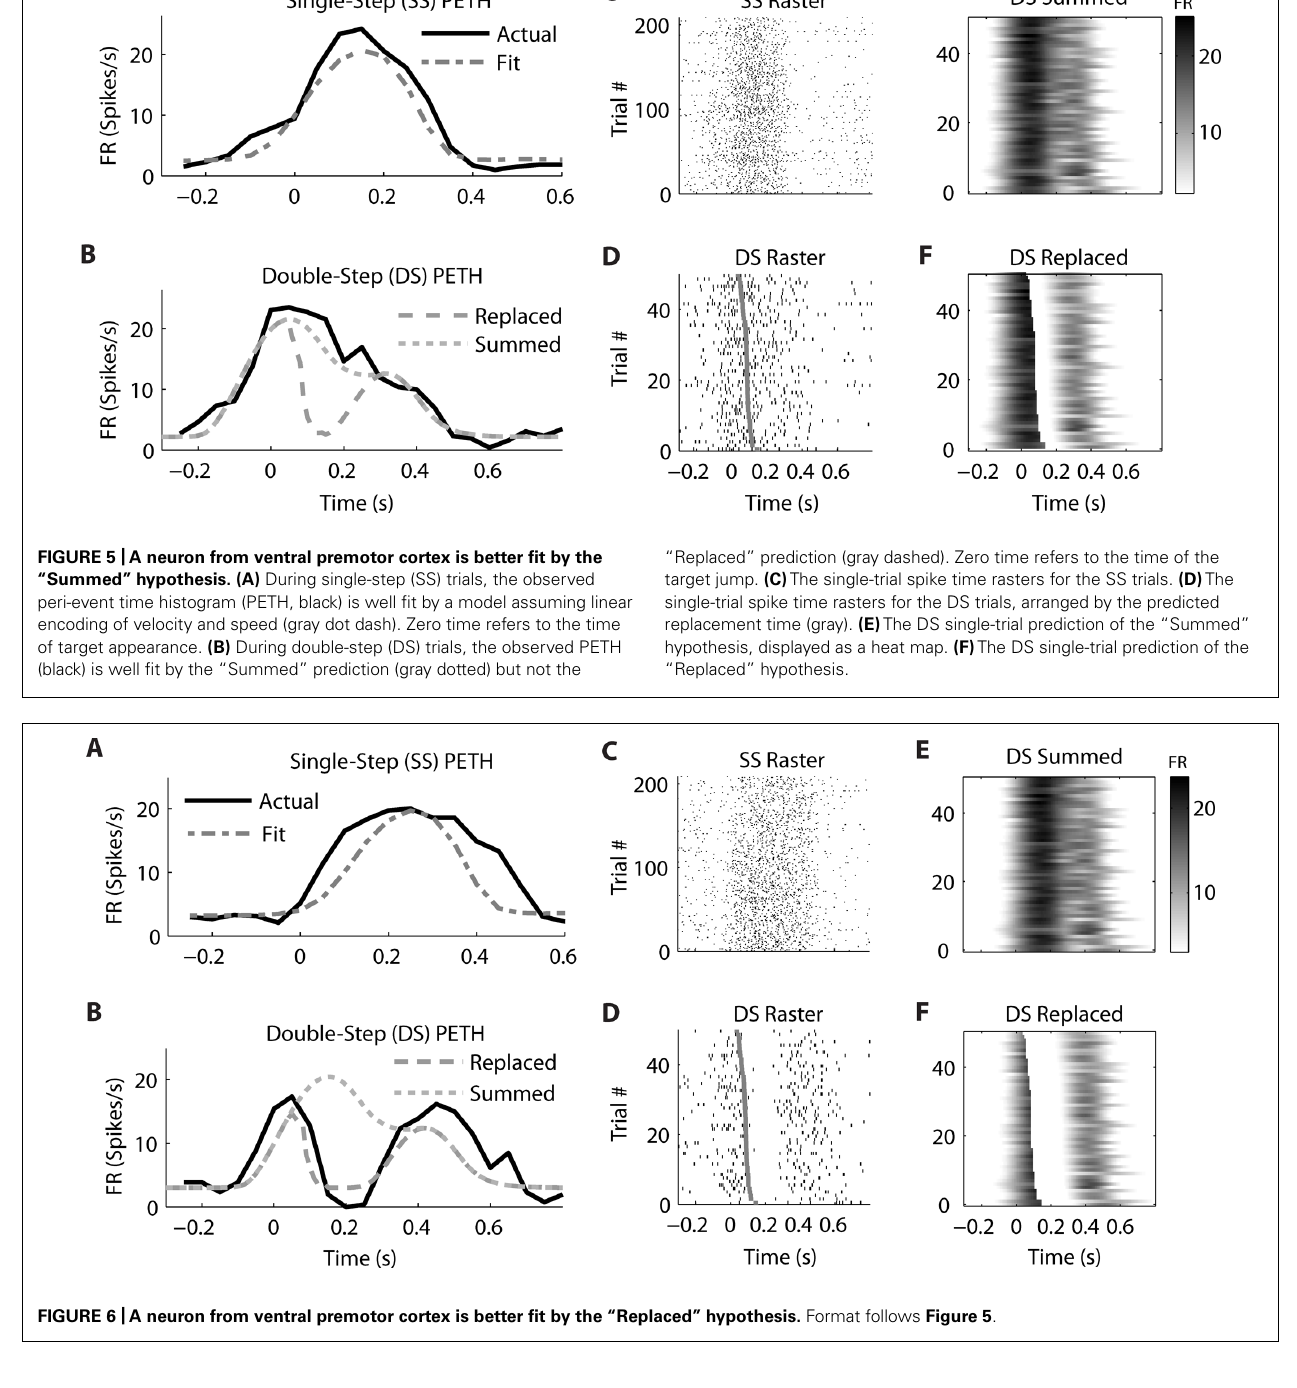
FIGURE 6 |A neuron from ventral premotor cortex is better fit by the “Replaced” hypothesis. Format follows Figure 5 .